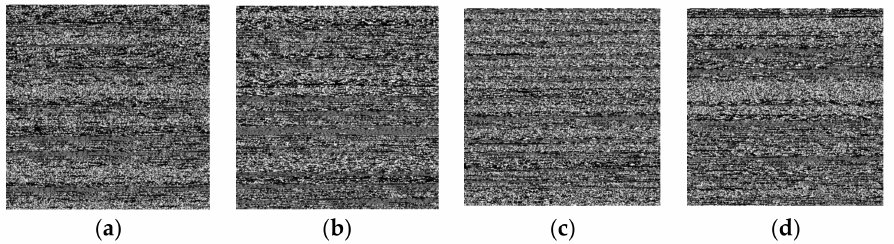
Figure 5. Malware images extracted from network traffic with a size 256 × 256: ( a ) Botnet; ( b ) Premium SMS; ( c ) Ransomware; ( d )